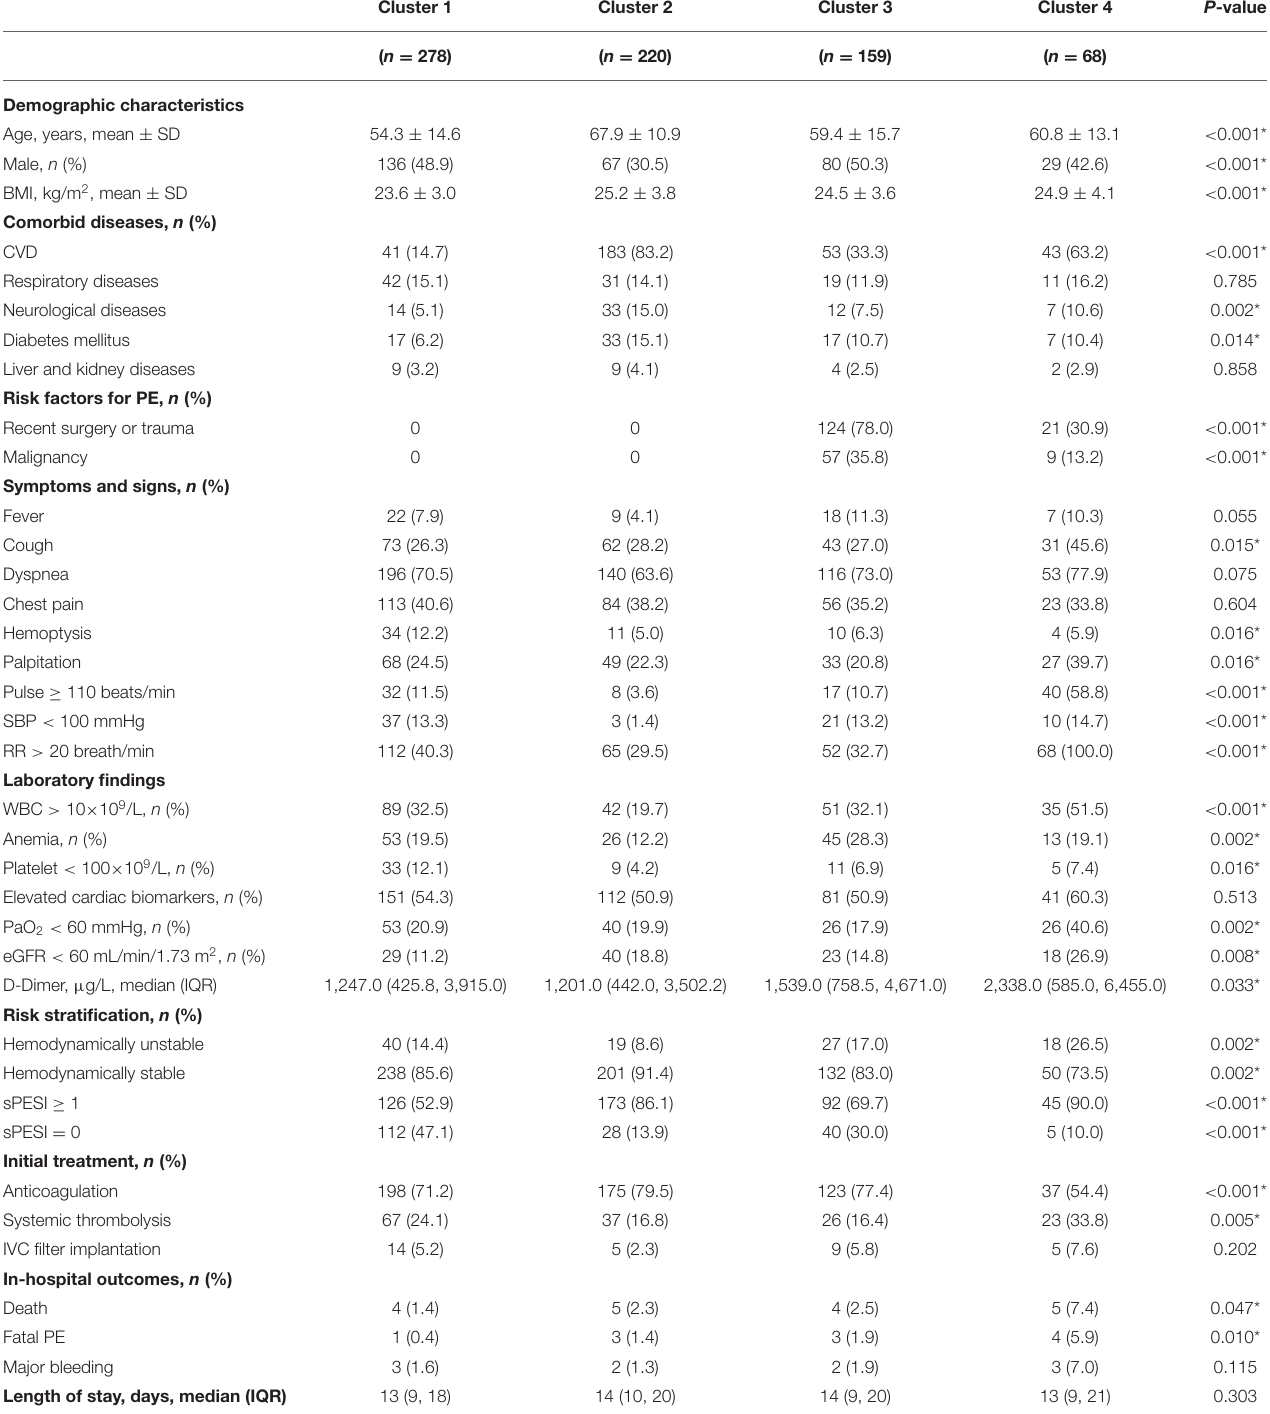
TABLE 4 | Characteristics of the 725 PE patients with syncope according to the four phenotypes identified using principal component analysis-based cluster analysis. Cluster